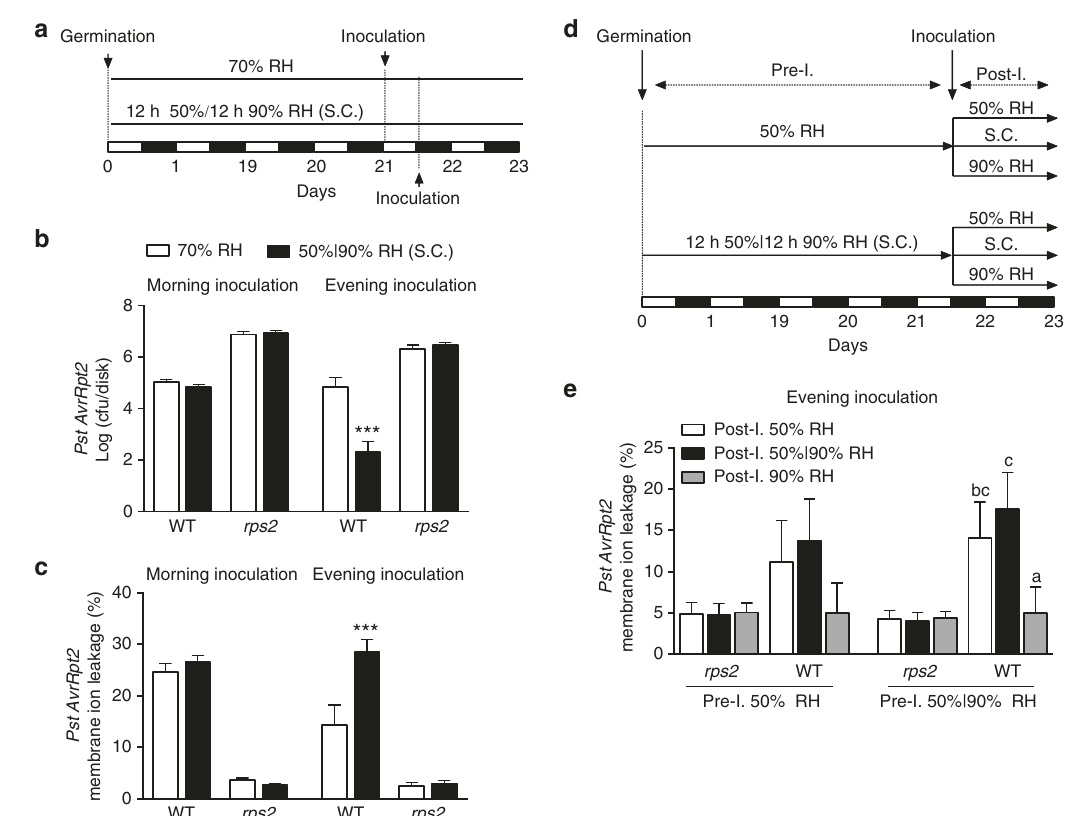
Fig. 5 Simulated natural conditions improve ETI in evening-inoculated leaves. a Work fl ow describing morning and evening infection experiments in b and c (Supplementary Fig. 6b, c). S.C. simulated natural conditions. b Quanti fi cation of Pst AvrRpt2 growth at 3 days post inoculation in 3-week-old WT and rps2 (AvrRpt2 receptor mutant) plants grown under LD under 70% RH (grey) or simulated natural conditions (black). Leaves were in fi ltrated with bacteria